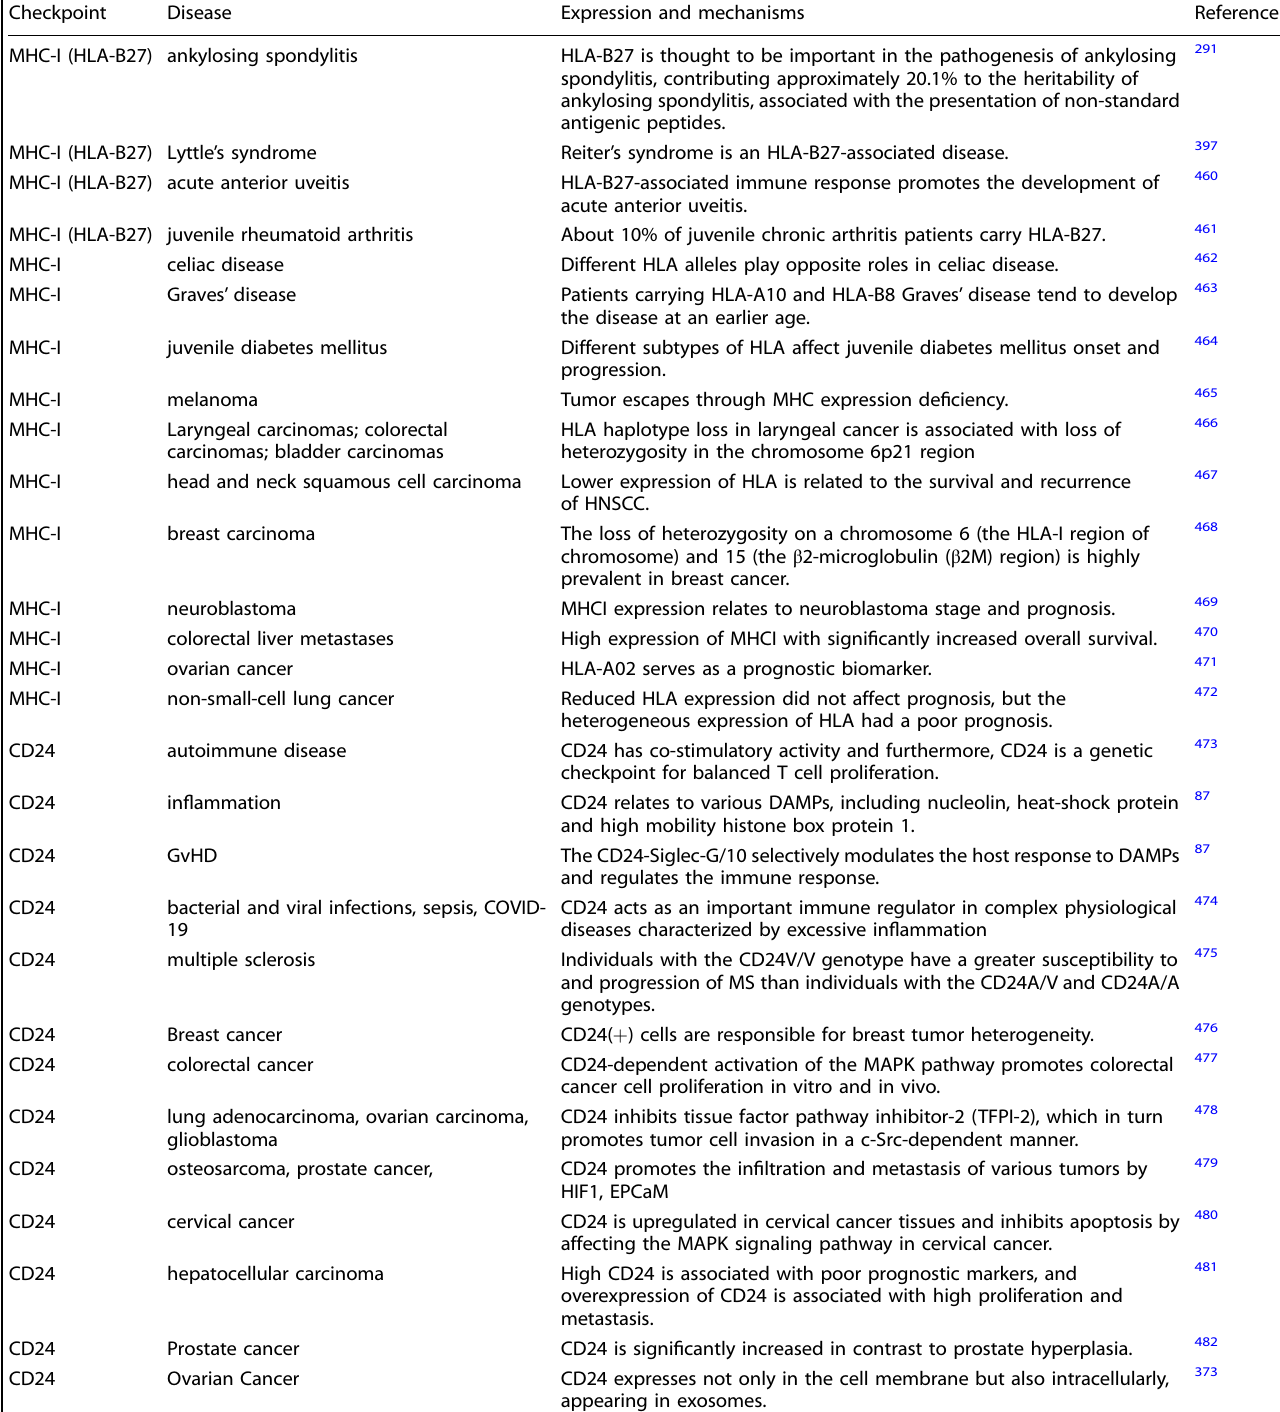
Proposed strategies and future perspectives for targeting CD47 Designing a CD47 antibody with weak binding to RBCs: The high expression of CD47 on RBCs means that RBCs bind to CD47 antibodies preferentially, 353 but it is still possible to develop antibodies with antitumor activity and without hematological toxicity since the molecular conformation of CD47 on tumor cells is distinct from that of CD47 on RBCs. 354 – 356 TJC4 was designed